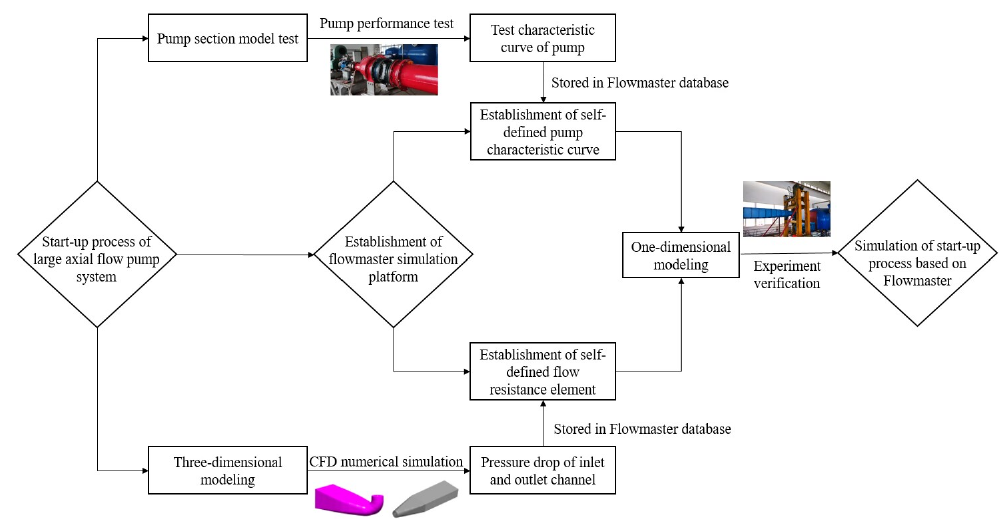
Figure 2. Flowchart of the start-up process’s simulation strategy.